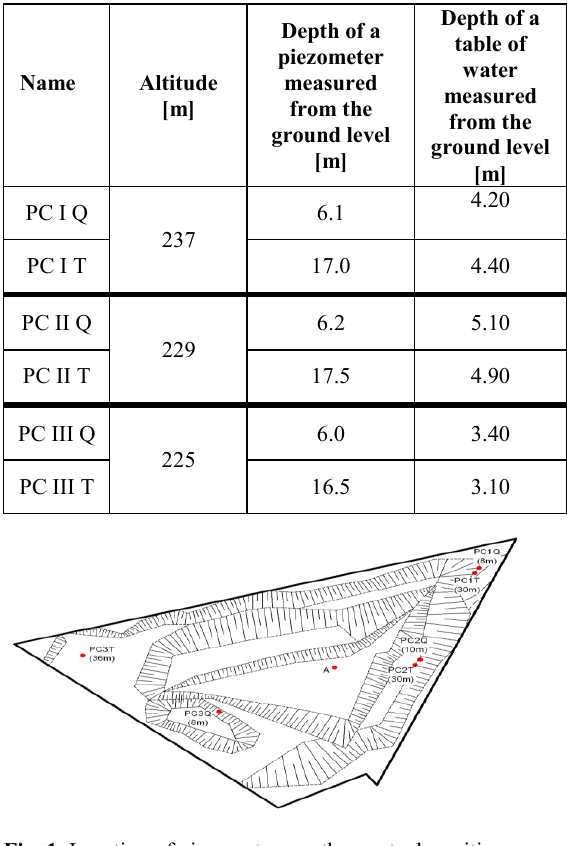
Fig. 1. Location of piezometers on the waste deposition landfill. The depth of piezometers is given in the